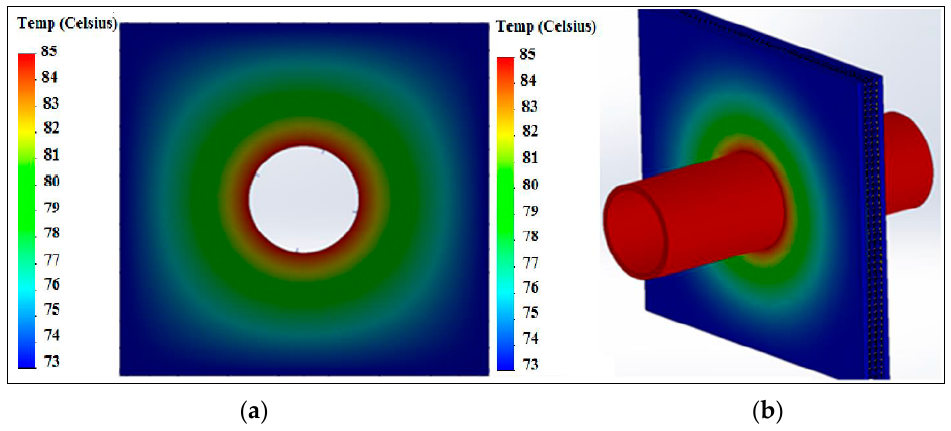
Figure 19. The contour thermal heat transfer temperature of the flat finned heat exchanger ( a ); The Centre of the fin is 85 °C and the fin edge is 73 °C ( b ).